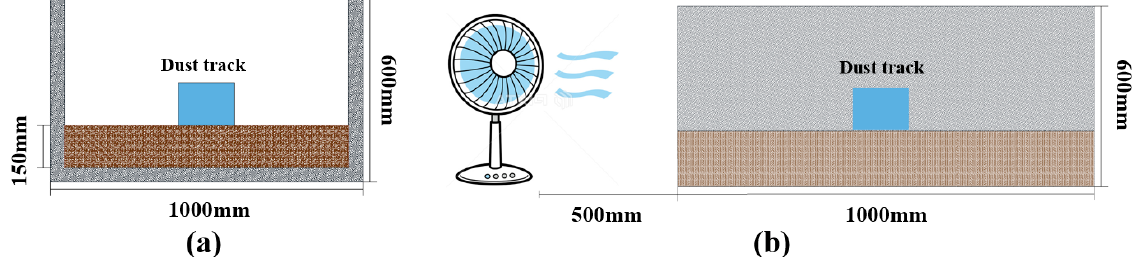
Figure 4. Dust measurement setup due to wind effect ( a ) Front view and ( b ) Side view.